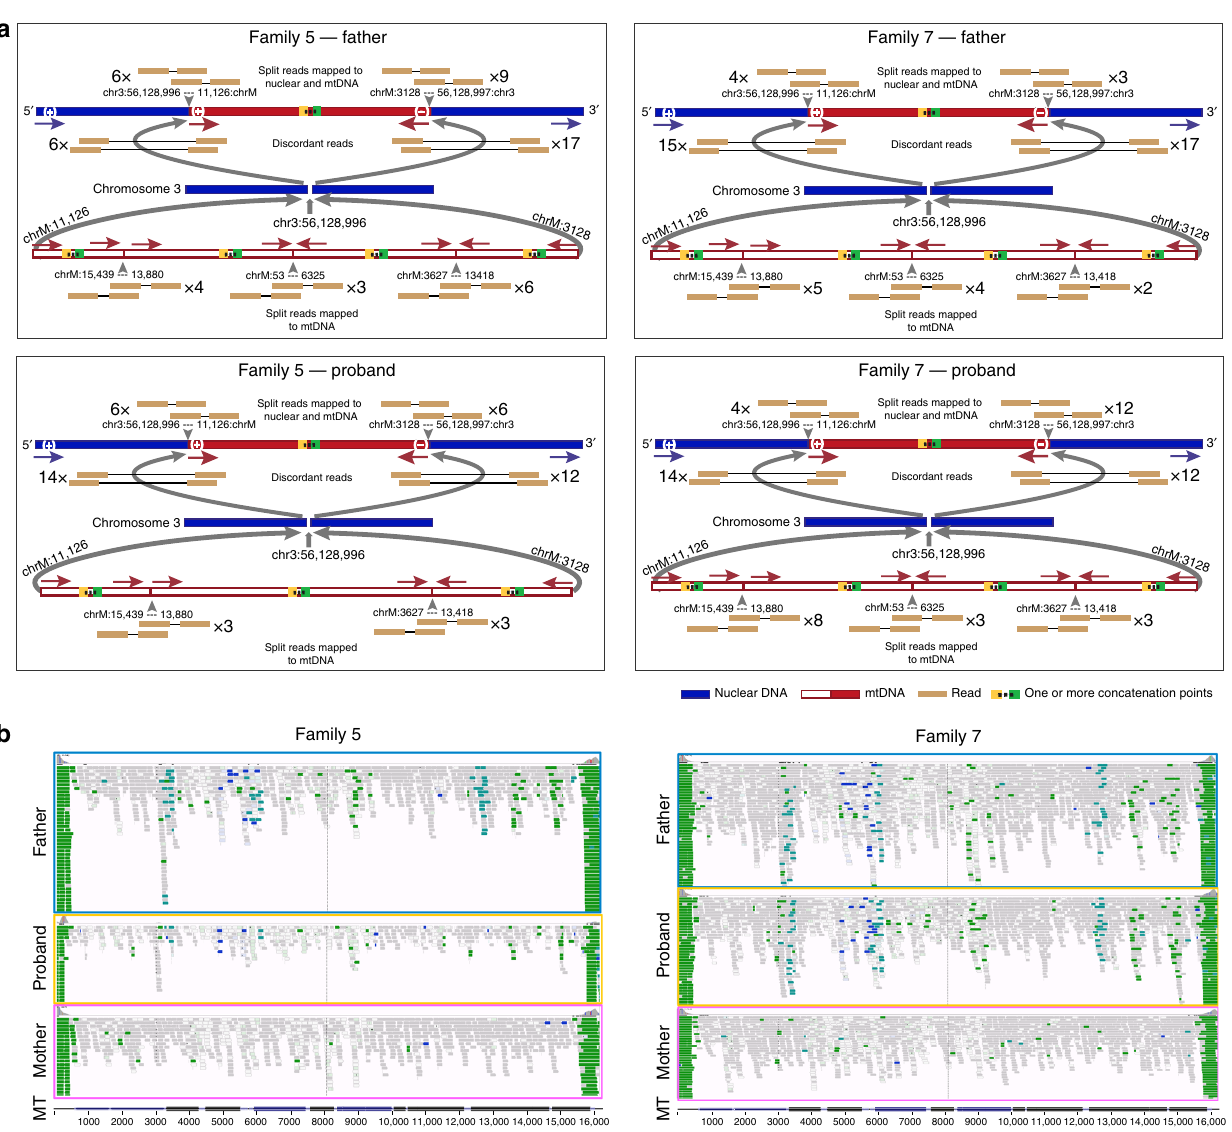
Fig. 4 De fi ning complex mega-NUMTs. a Split reads align to both mtDNA-derived and nuclear DNA sequences (top). Discordant reads are paired reads where one end aligns to mtDNA-derived sequences and the other end aligns to nuclear DNA sequences (middle). Possible constructed concatemer is shown at the bottom with observed supporting split reads. The positions of breakpoints (bp) are shown on both nuclear DNA (top) and mtDNA (bottom). b IGV screenshots showing the reads not properly aligned to mtDNA-derived sequences. The reads are coloured by pair orientation. Many read pairs with anomalous pair orientations in the fathers and probands support the mtDNA-derived sequence rearrangement. In Family 5 and Family 7, the fathers and offspring carried the same NUMT, they also carried the same nuclear-mtDNA junctions and the junctions within mtDNA-derived sequences. The de fi ned junctions by split reads from the other fi ve families are included in Supplementary Fig.